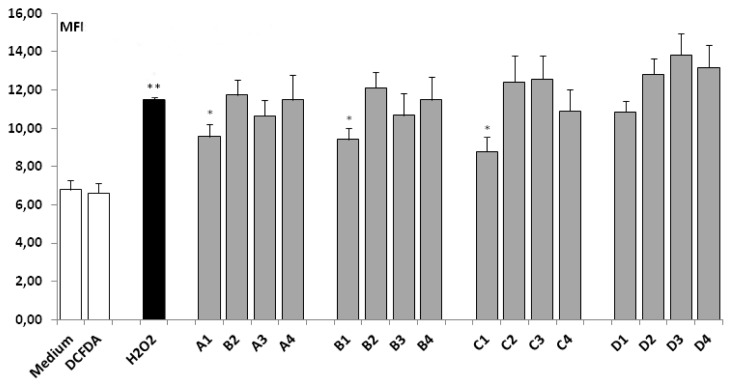
MTT analysis of PC12 cell viability after different treatments: Medium, DCFDA (2′,7′-dichlorofluorescein diacetate) H2O2 (200 μmol/L), A ((+/−)-thioctic acid), B ((+)-thioctic acid, piperazine salt), C ((+)-thioctic acid, lysine salt), and D ((−)-Thioctic acid). The Arabic numbers (1, 2, 3 and 4) close to the letters represent the different concentrations (100, 50, 20 and 10 μmol/L, respectively) for every treatment. The data were expressed as the mean of fluorescence intensity and were the mean of ± SE of three different experiments. ** p < 0.05 vs. medium or DCFDA alone; * p < 0.05 vs. H2O2 only.